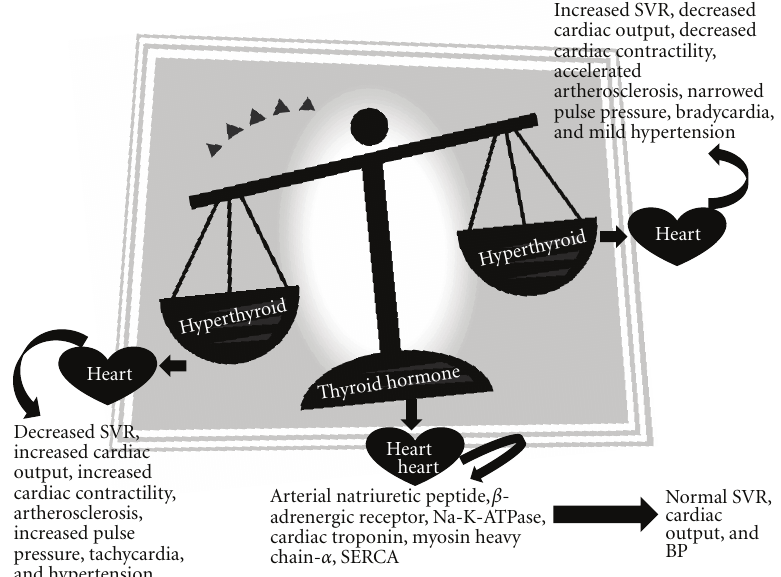
Figure 1: E ff ects of thyroid hormone on cardiac